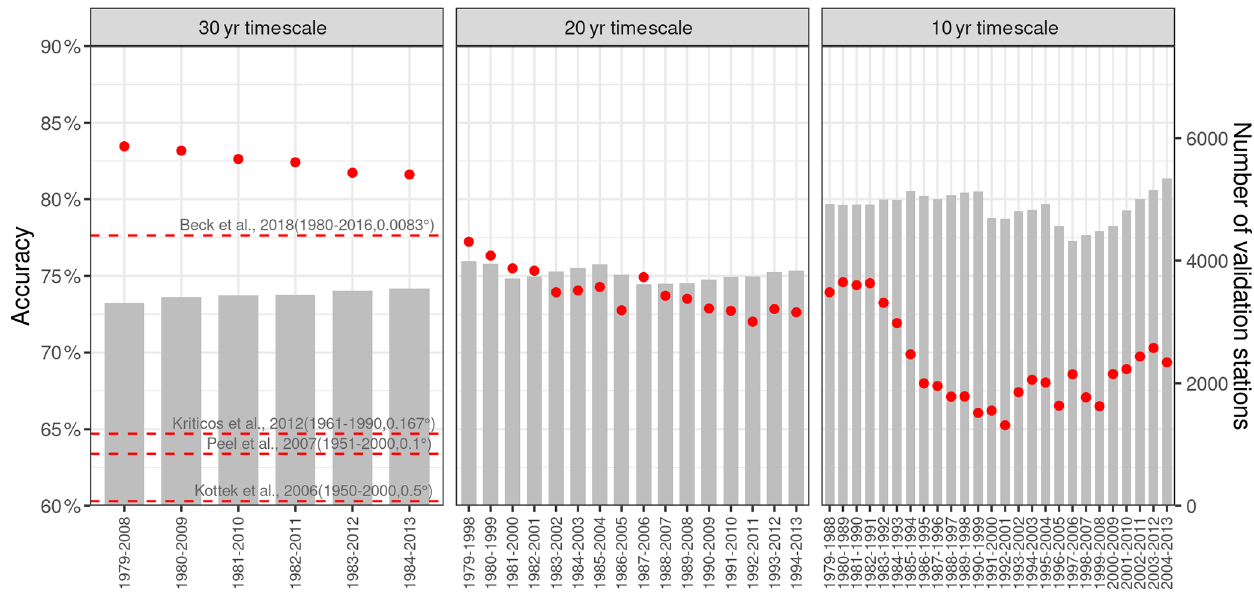
Figure 7. Validation of downscaled data of bioclimatic variables and the generated Köppen–Geiger climate